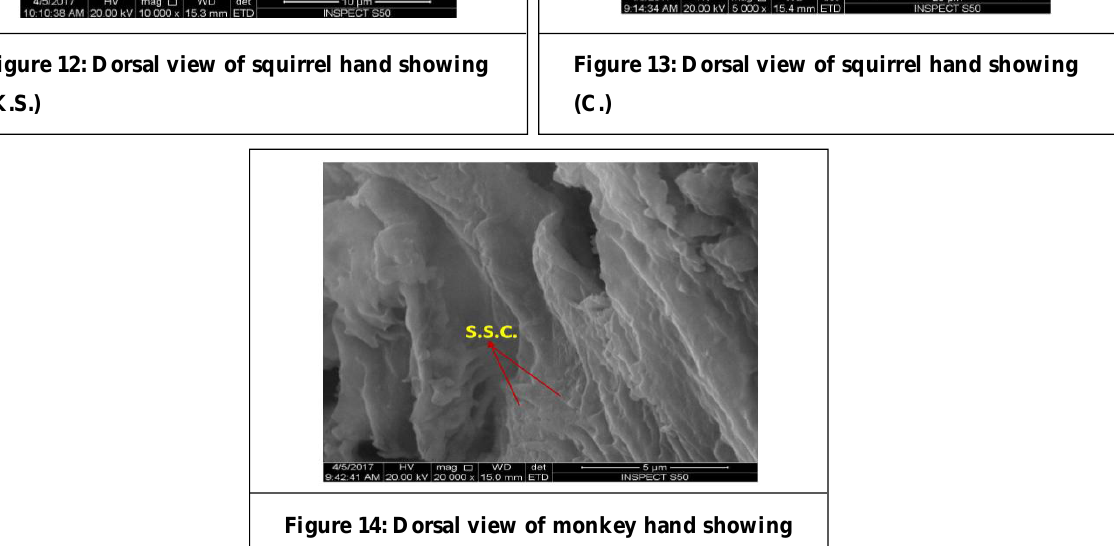
Figure 12: Dorsal view of squirrel hand showing (K.S.)